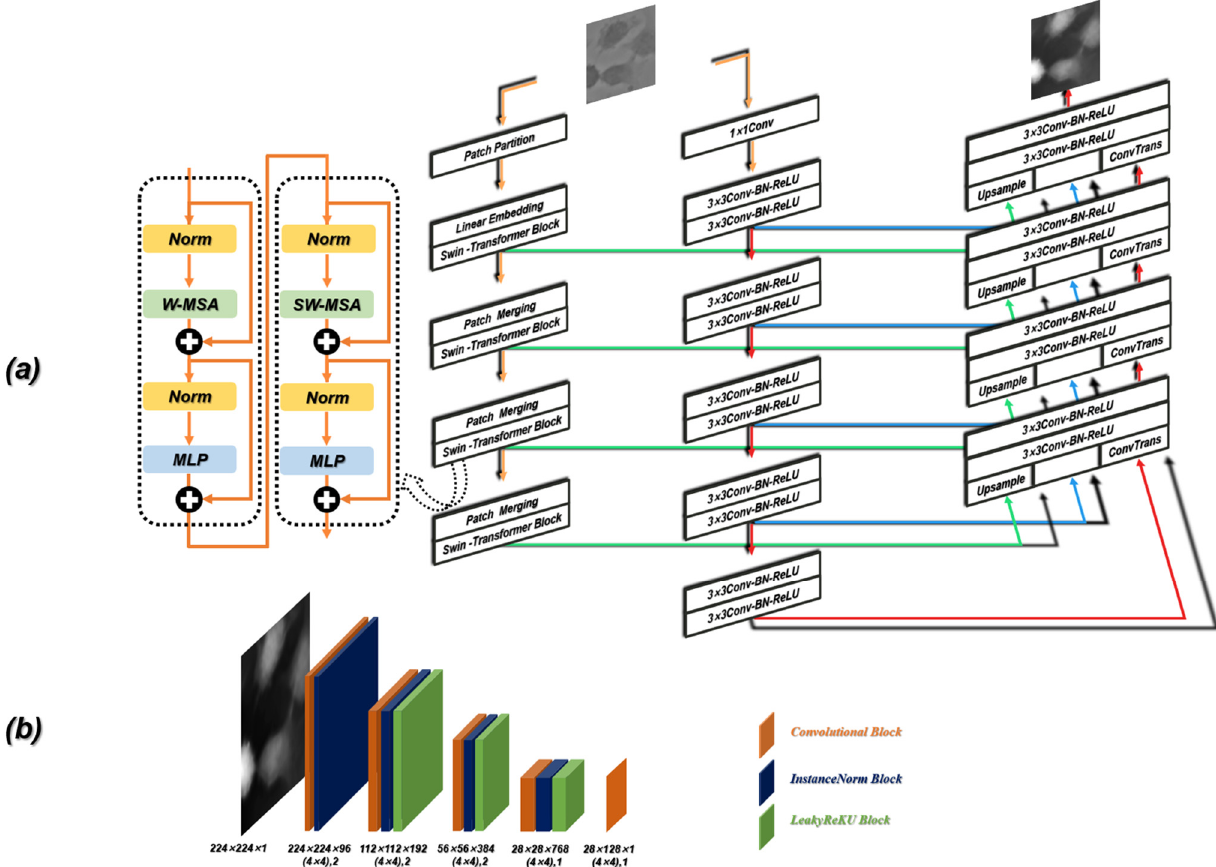
Figure 4. Detailed schematic of the ContransGAN architecture. ( a ) The schematic of the generator. ( b ) The schematic of the discriminator.